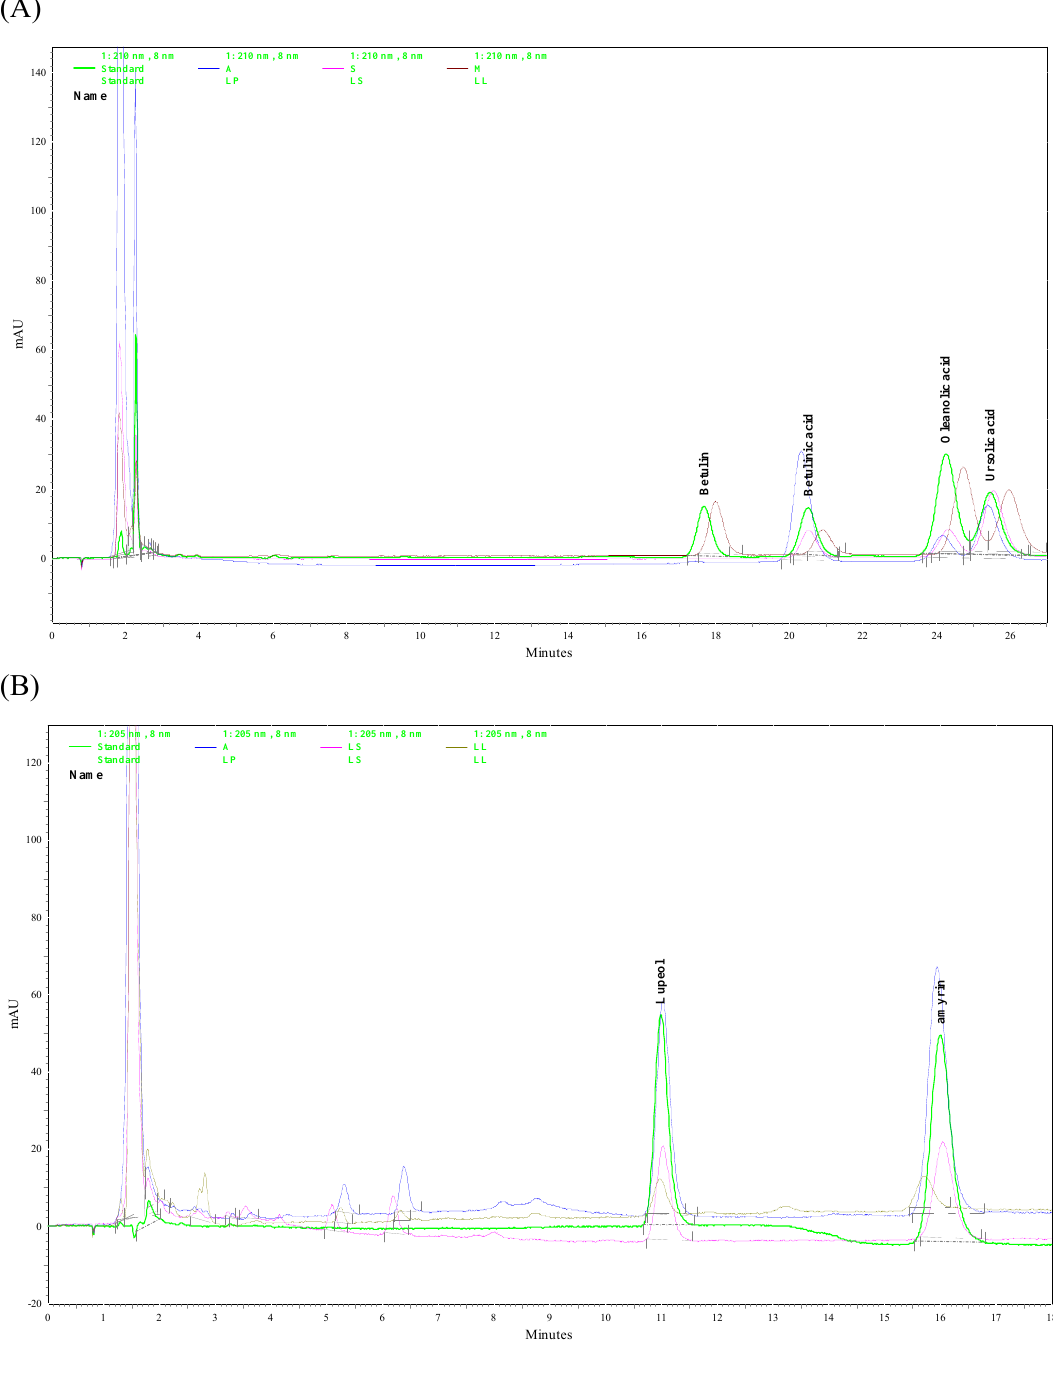
Figure 6. HPLC chromatograms of Ligustrum plants. (A) Detector responses at 210 nm. (B) Detector responses at 205 nm. Green trace: Standard, Blue trace: L. pricei (LP), Pink trace: L. sinens (LS), Brown trace: L. lucidum